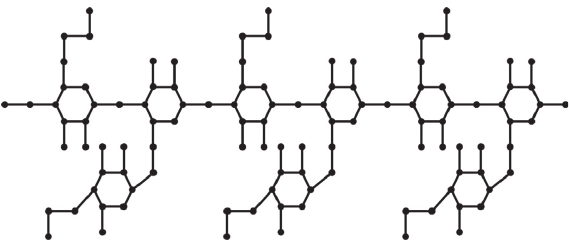
Figure 4: The molecular graph of CMG for n � 3. Table 2: The edge partition of the molecular graph of hydrox- ypropyl guar and carboxymethyl guar based on degrees of the end vertices of each